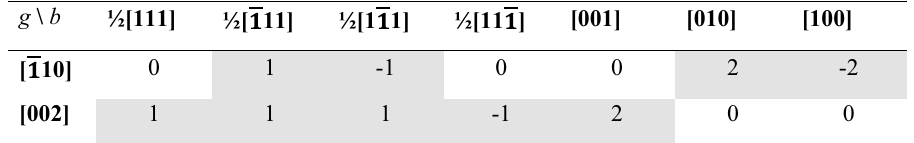
Table 2. Visibility criterion for dislocation loops in diffraction contrast microscopy.